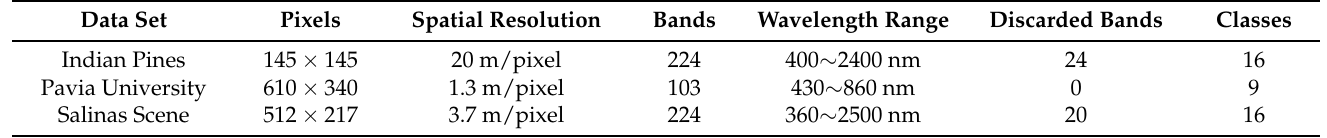
Table 1. Indian Pines, Pavia University, and Salinas Scene datasets